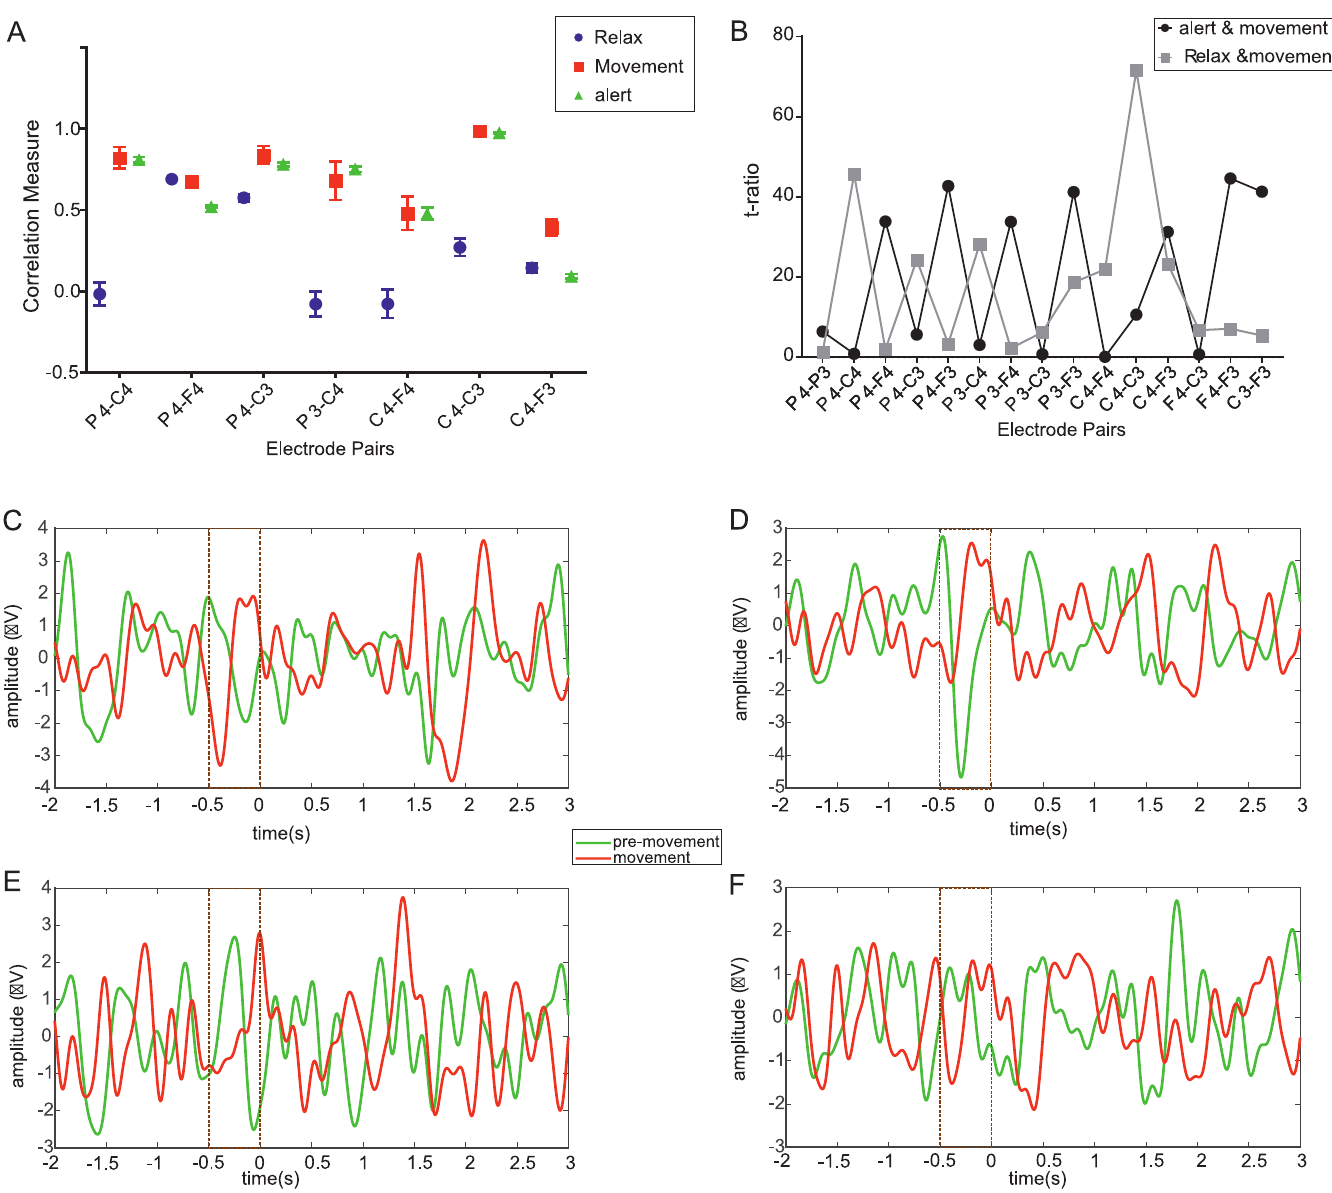
Fig 3. Temporal correlations across MRCPs from EEG electrode regions differentiate movement tasks. (A) Correlation measures for central regions (C3-C4) electrode pair has indicated higher correlation (r = 1) for movement and ‘alert’ condition tasks whereas for a lower correlation measure (r) of 0.3 was estimated for the ‘relax’ task., P4-F4 electrode pair has indicated a measure of 0.5 for premovement and relax tasks and 0.6 for movement task. The electrode combination of C3-C4 for movement and “alert” condition had higher correlation measure compared to P4-C4, P4-F4, P4-C3, C4-F4, C4-F3 combinations. (Blue circle–“relax task”, Red square–“movement task”, Green triangle–“alert/premovement” task (B)Correlation measure of various electrode pair combinations was statistically compared for the tasks using t-test. and C3-C4 electrode combination were significantly different for “relax” and movement tasks indicating central region electrodes could be decisive in differentiating “relax” and grasped movement tasks. (C) potential amplitude decreases in 296% from premovement to movement in the central electrode regions (D) Parietal regions has shown 164% decreased in amplitude (E) Frontal regions has shown 133% decrease and (F) Occipital regions has shown 230% decrease in potential amplitude before 500ms to onset of movement. (Green line–“premovement task” and Red Line indicates “movement” task).